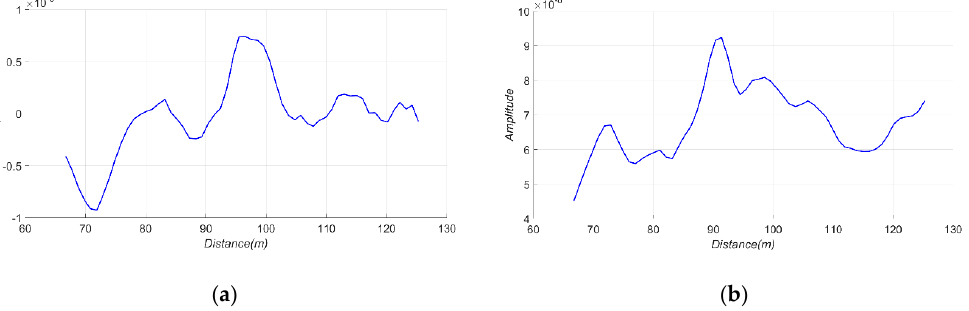
Figure 20. ( a ) Mean and ( b ) variance at different distances.